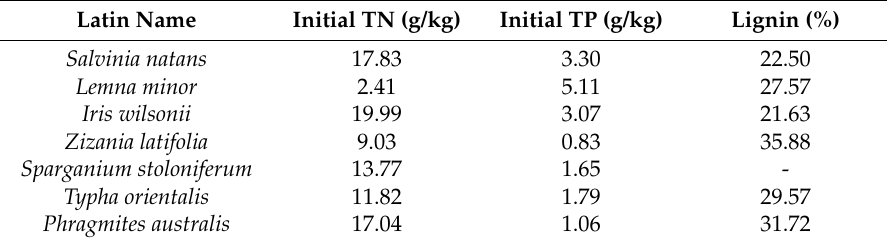
Table A2. The initial litter traits of different plan used in the